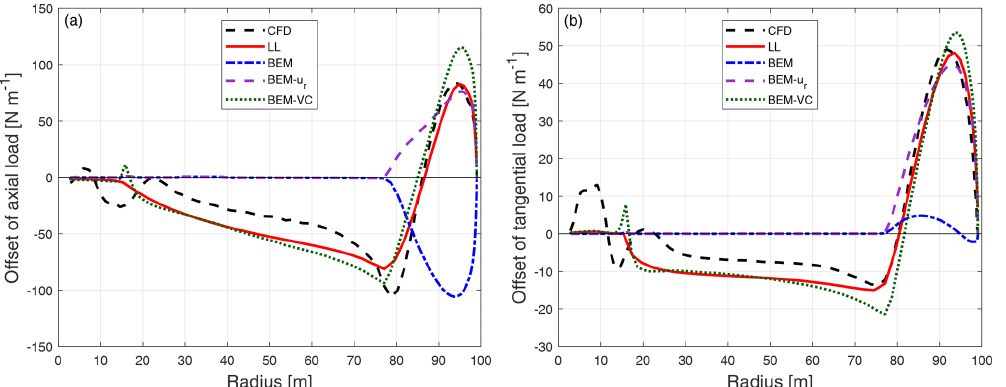
Figure B2. Comparison of the difference of the axial load (a) and tangential load (b) of the dihedral blade W-3 compared to the baseline blade calculated from different aerodynamic models.